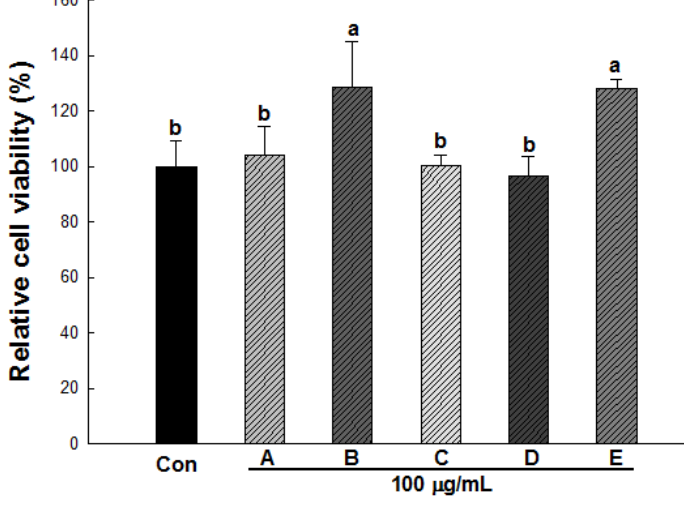
Figure 3. Effect of wild herb extracts on the cell viability of 3T3-L1 preadipocytes. Cell viability was determined using the XTT assay. Con, control cells; A, Aster scaber ; B, Ligularia fischeri ; C, Kalopanax pictus ; D, Codonopsis lanceolata ; E, Cirsium setidens . All values are presented as the means ± SD. Bars with different letters indicate statistically significant differences among groups at p < 0.05 by one-way